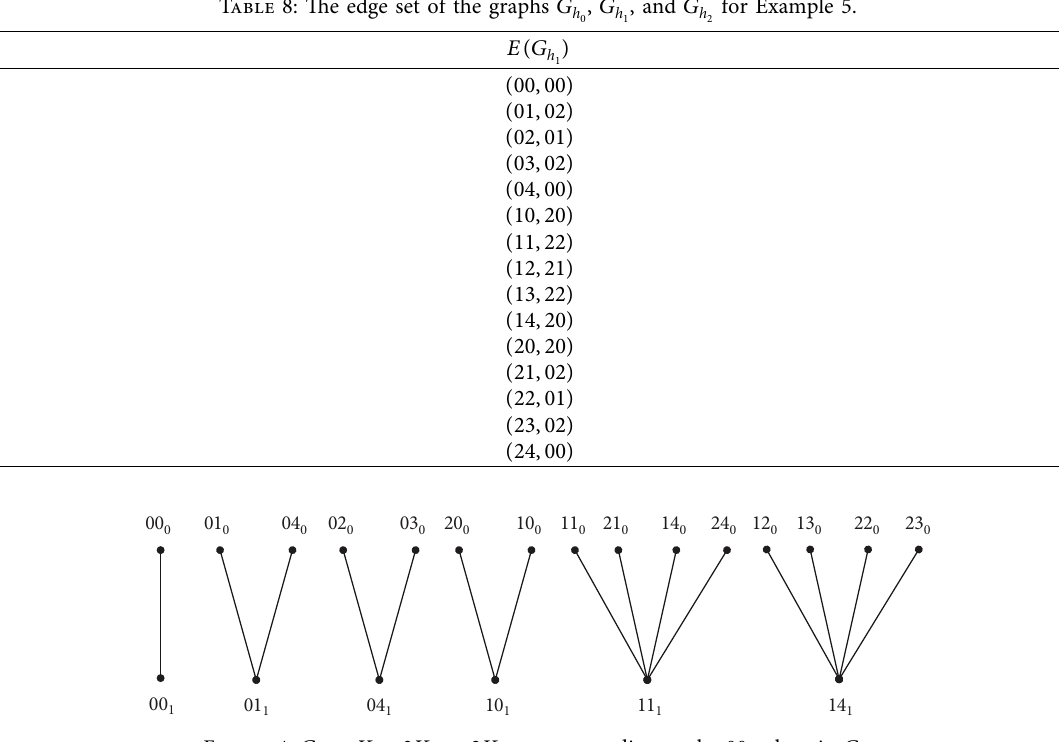
� K ∪ 3 K ∪ 2 K corresponding to the 00 values in C h 0 2 1 , 2 1 , 4